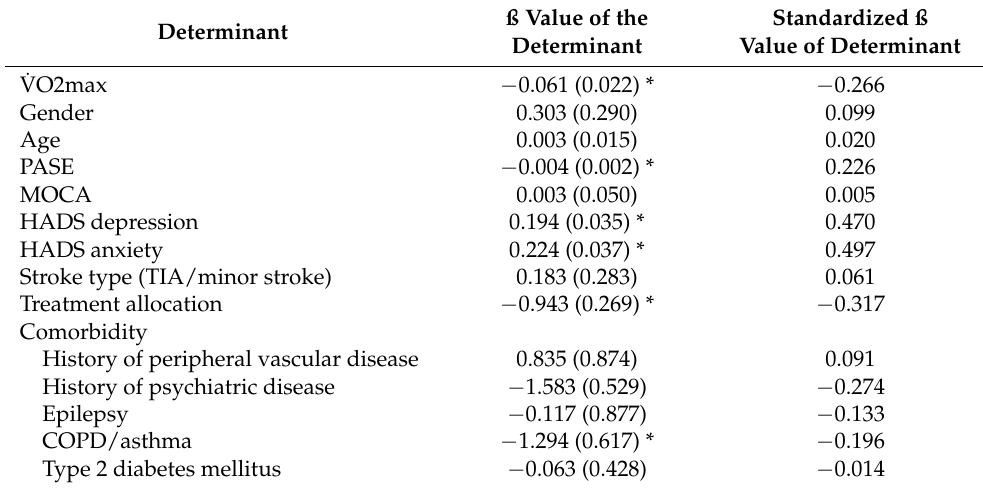
Table 2. Bivariate association between FSS and candidate determinants at one year (N =